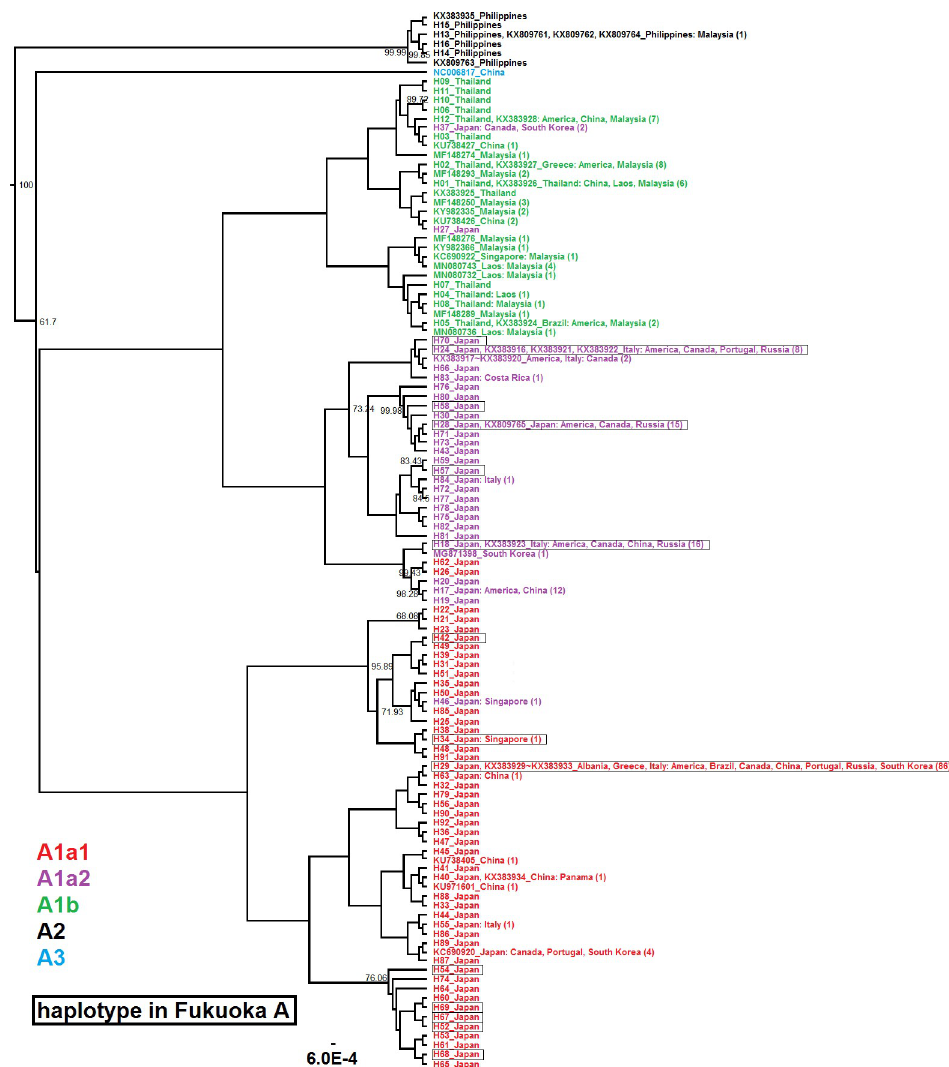
Fig 8. Phylogenetic tree of Ae . albopictus (total 108 taxa). Taxa are labeled with accession numbers and countries or haplotype name (H1-H84) and countries, and colored by haplogroups as defined by Battaglia et al. [60]. Areas which had identical sequences are listed after a colon symbol. Figures in parentheses show the number of identical sequences found in the 524 sequences. Support values above the branches indicate posterior probabilities ( > 50) of Bayesian Inference with MCMC. Haplotypes found in Fukuoka A are highlighted (enclosed in